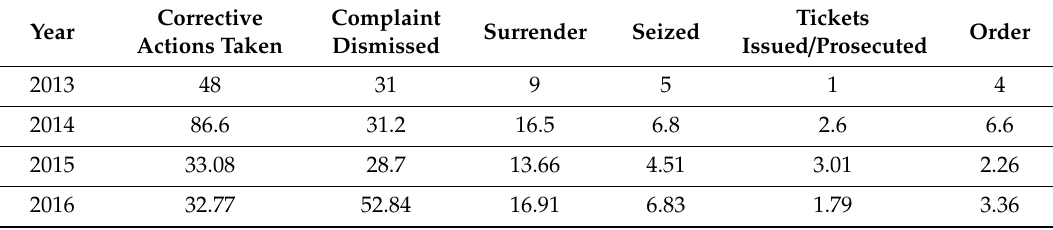
Table 6. Chief Veterinary O ffi ce Inspection Outcomes where Non-Compliance is Identified, 2013–2016 (Percentages).